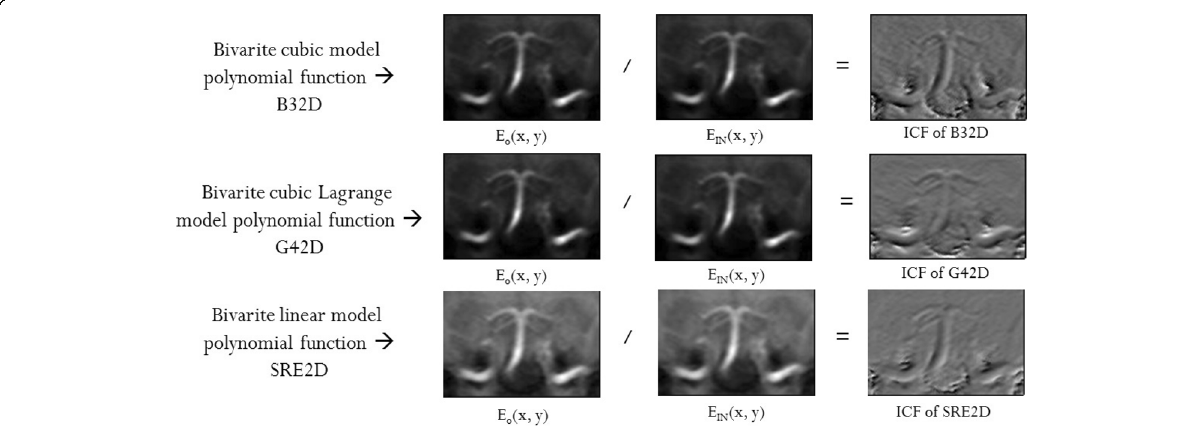
Fig. 2 Intensity-curvature functional of the three model functions. The intensity-curvature functional (ICF) is the ratio of the intensity curvature terms (ICT) before (E o (x, y)) and after interpolation (E IN (x, y)). Here, the ICF appears as the HPF even though the ICTs are not HPFs. These correspond to the cases when the convolutions of pixel intensity values in the defining equation of the ICF are not responsible for the creation of the high pass (HP) filtering effect, which shows up in the ICF images. The HPF-like appearance of the ICF in such cases can be attributed to the effect of the ratio between ICTs. This figure demonstrates that the gradients embedded in the formulation of the ICTs are not the reason for this